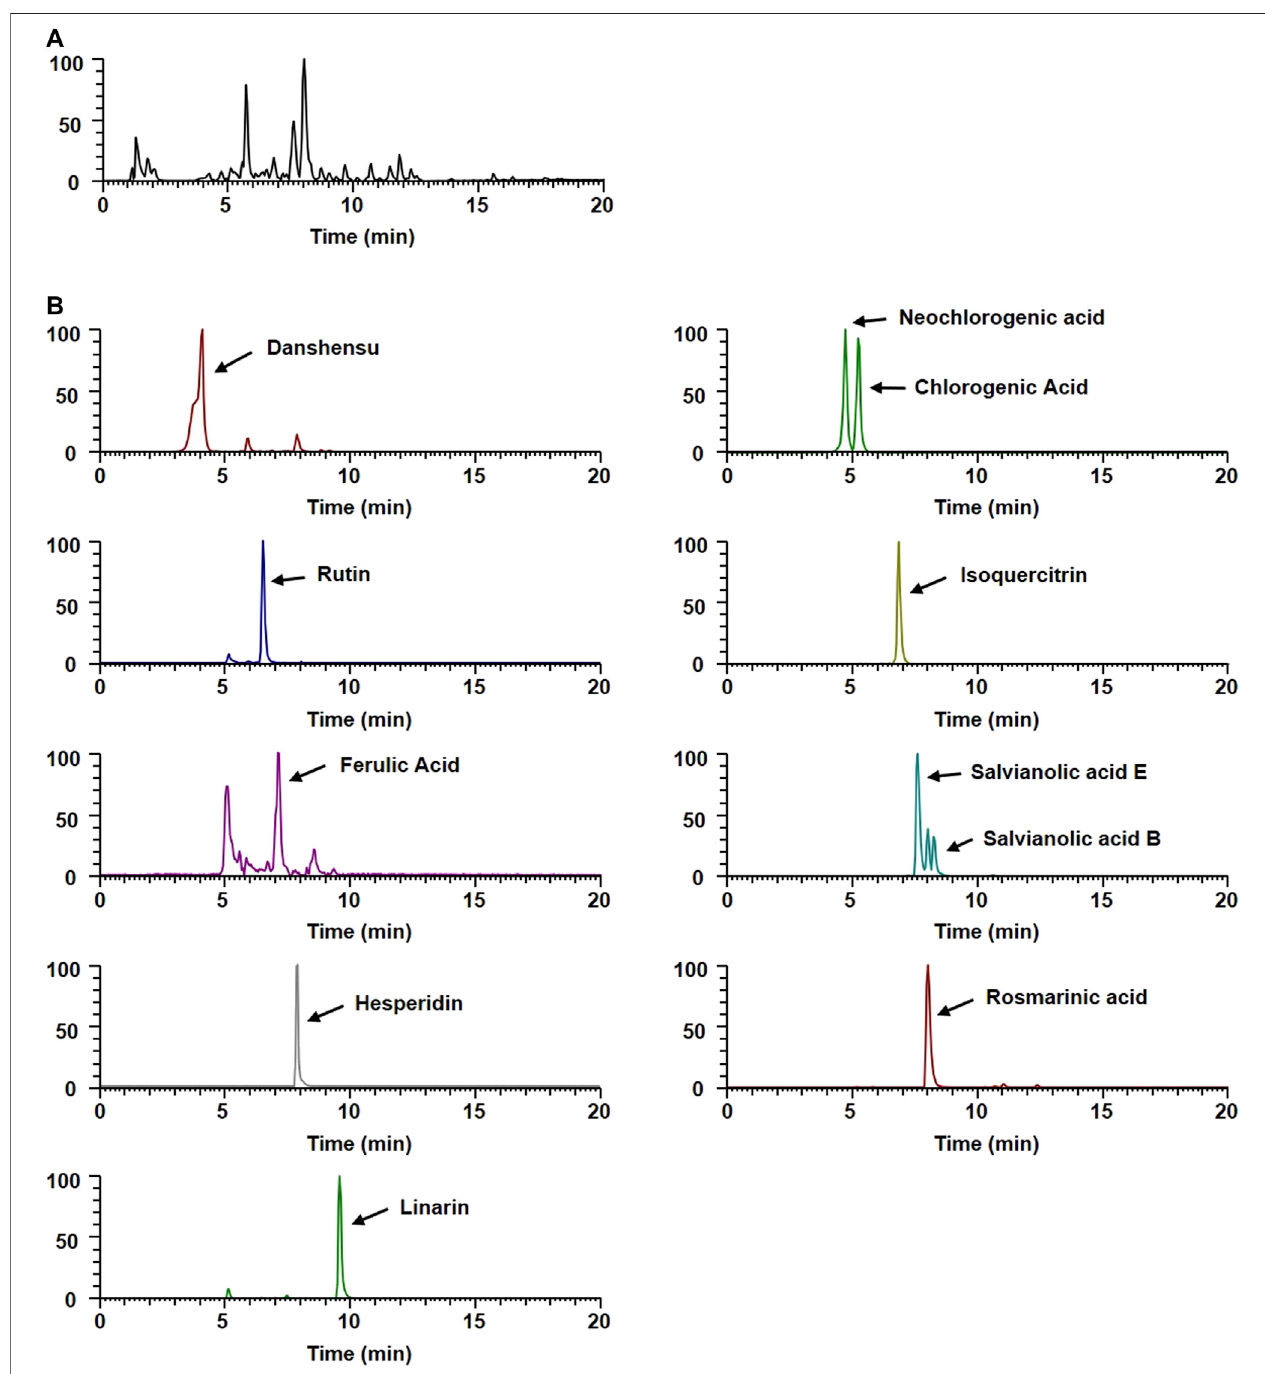
FIGURE 4 | UHPLC – MS/MS analysis of WEMA. (A) Base peak chromatogram of WEMA. (B) Extracted ion chromatograms of identi fi ed phytochemicals.